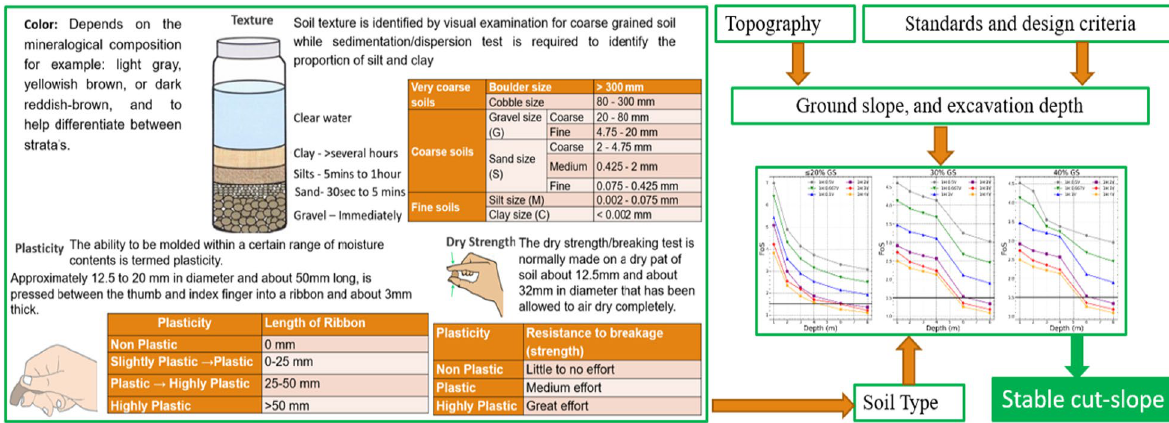
Fig. 8 General methodology proposed for selecting appropriate cut